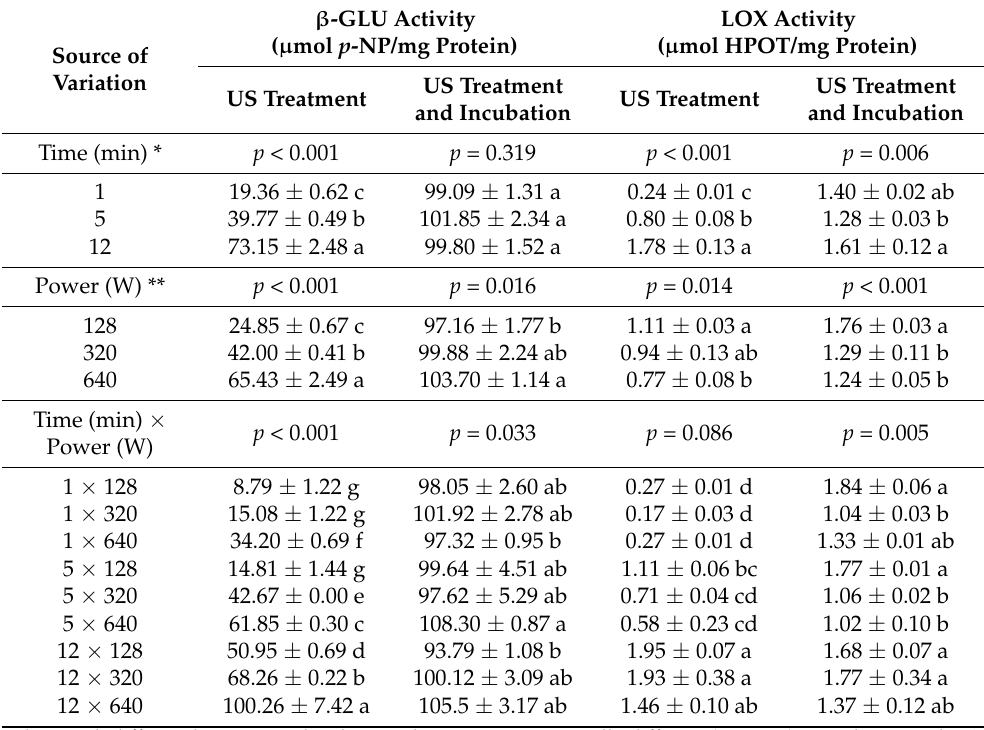
Table 2. Enzyme activity of β -glucosidase ( β -GLU) and lipoxygenase (LOX) after ultrasound (US) treatment and after additional incubation of the model systems at 25 ◦ C for 30 min as an effect of time and power, expressed as the least square mean ± standard